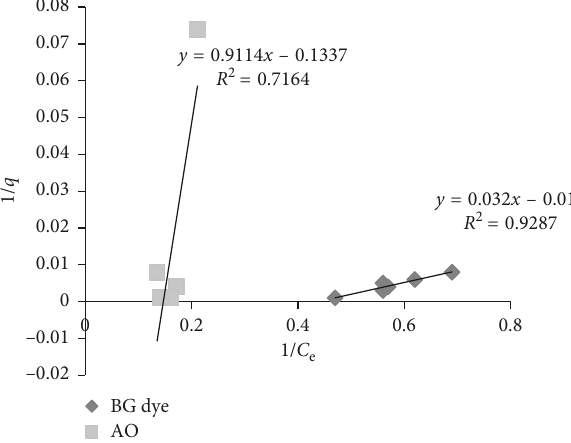
Figure 8: Graphical representation of comparative Langmuir isothermal parameters.